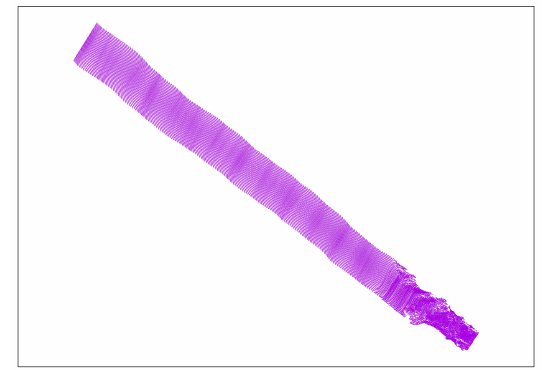
Figure 15. D-P thinning method of 16% thinning rate